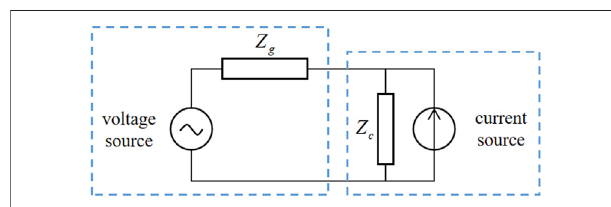
FIGURE 1 | Generic model of multi-frequency oscillation analysis based on sequence impedance